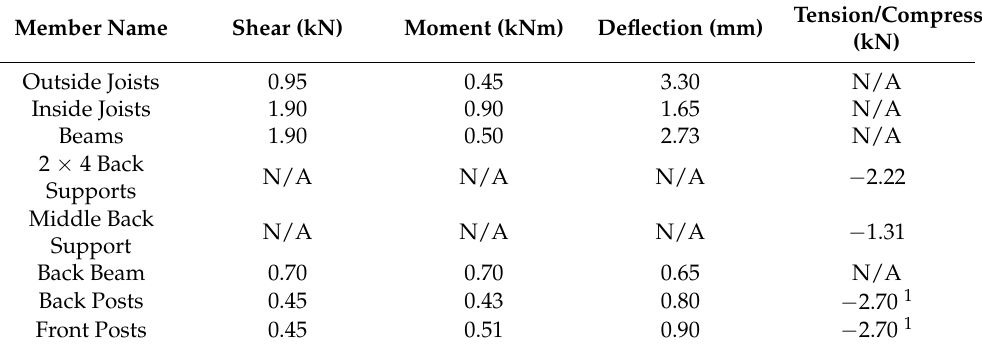
Table 5. Forces and deflections of structural members for the variable angle rack in London, Ontario, under the worst-case design